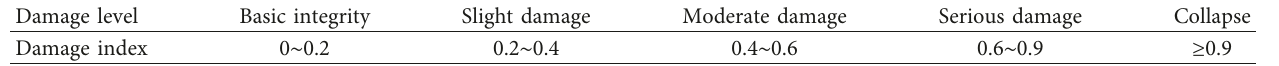
Table 1: Component damage index value at different damage